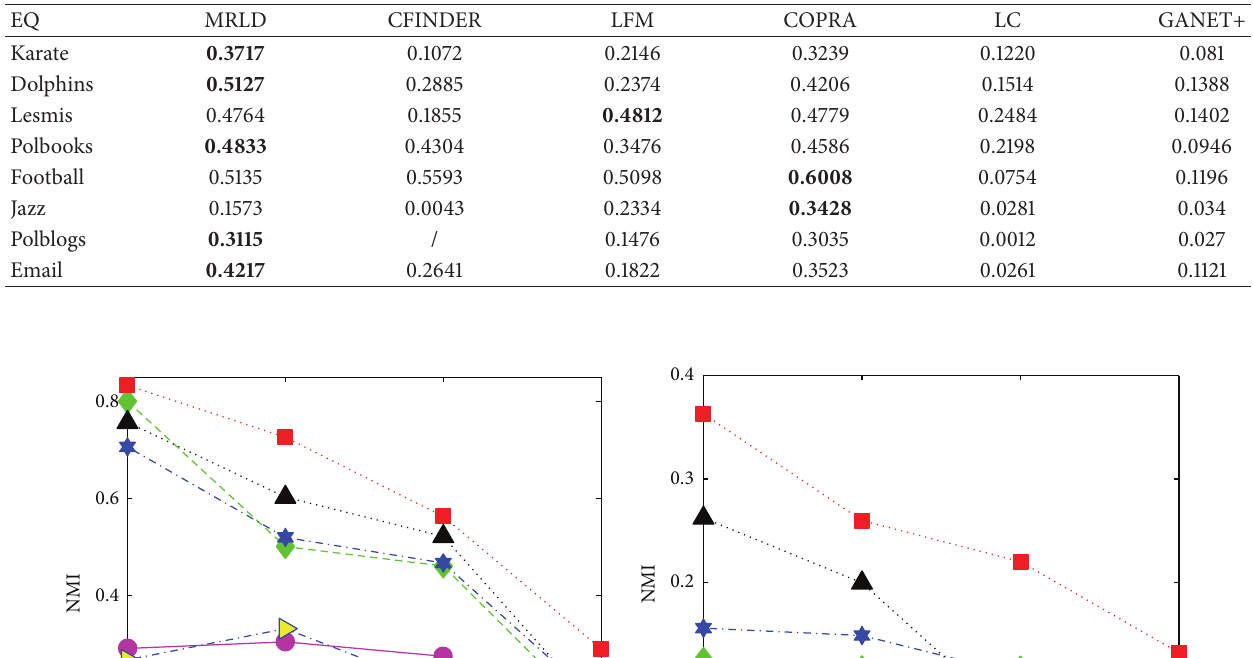
Table 2: Comparison of MRLD with other algorithms in terms of EQ.